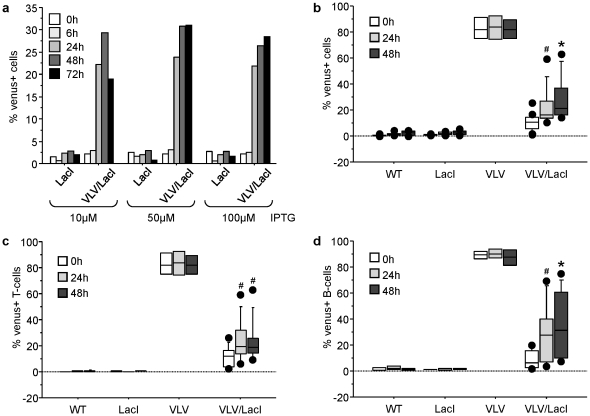
Transgene silencing and re-expression of transgene expression in vitro.Primary cells derived from peripheral blood of VLV/LacI double transgenic mice were put in culture and stimulated with graded doses of IPTG. FACS analysis was performed at the indicated time points to monitor levels of Venus+ cells (a). Peripheral blood lymphocytes from mice of the indicated genotypes were stimulated with IL-2+PMA+ionomycin to drive T-cell activation or IL-2+IL-4+IL-5+LPS to drive B-cell proliferation. Proliferating cells were treated with 50 µM IPTG on day 3 after mitogen stimulation and levels of Venus+ cells were quantified by FACS analysis on all cells (b), as well as T-cells (c) or B-cells (d). Results from four independent experiments and 4-9 animals/genotype (wt = 5, LacI n = 5, VLV n = 4, VLV/LacI n = 9) are represented as box plots. Box length equals interquartile range. Circles represent minimal and maximal values; *p<0.001; #p<0.05. F2 generation offspring of VLV founder A3 were crossed with LacI mice. Single-, double-, and non-transgenic littermates were used for analysis.